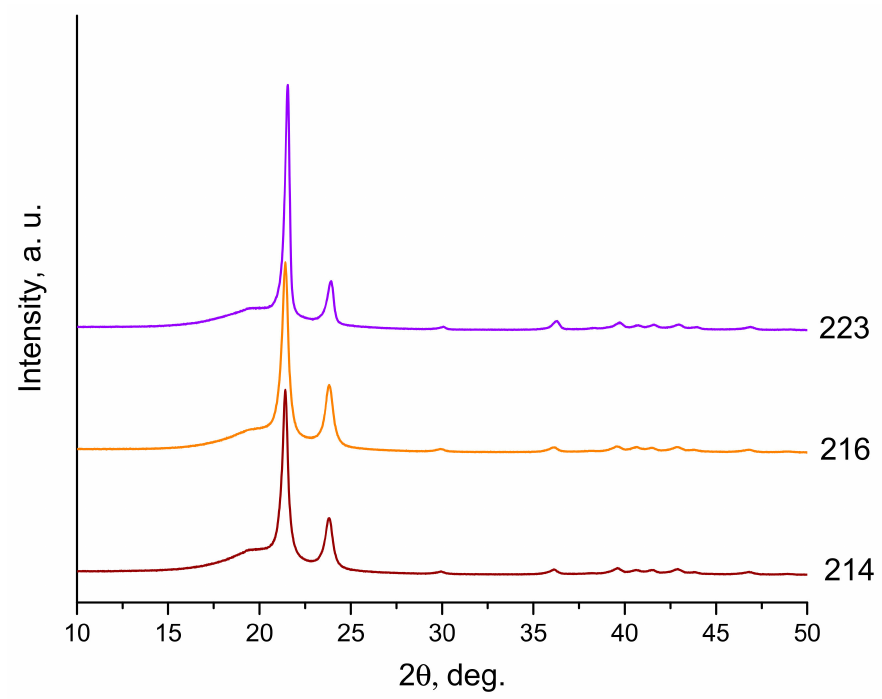
Figure 9. XRD patterns of compacts made by the CIC method from activated (214) and non-activated (216) powders and from a mixture of UHMWPE + 0.3 wt.% NDC